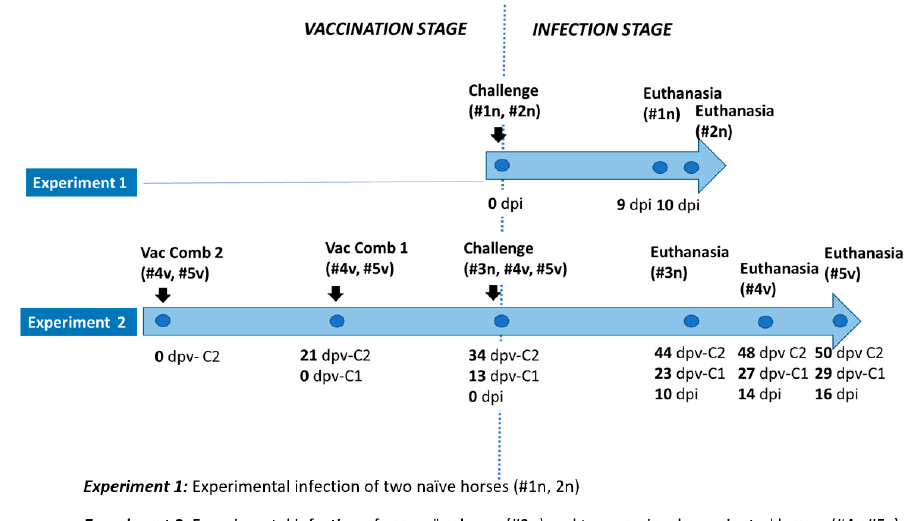
Figure 1. Study design and milestones.